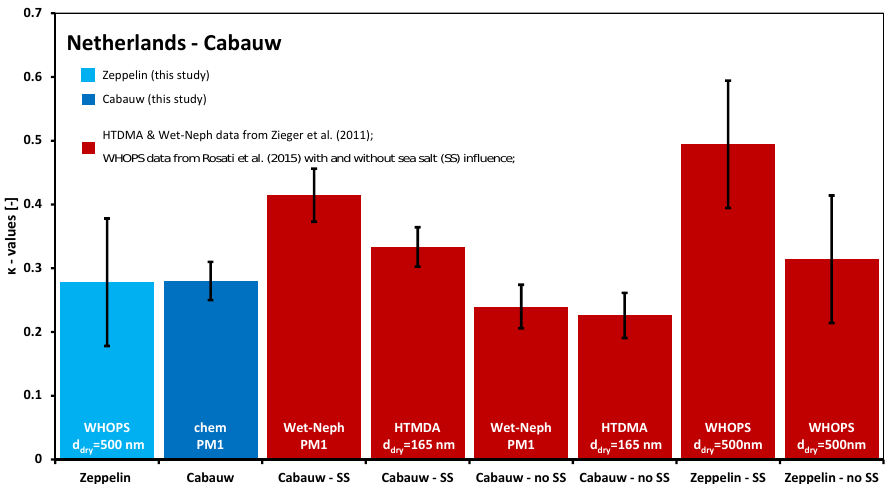
Figure 15. Inter-comparison of mean κ values and their temporal variability measured on board of the Zeppelin NT (light blue bar) and at the ground (dark blue bar) during the PEGASOS campaign on 24 May 2012 in the Netherlands. Additionally, results from two separate campaigns reported in the literature are shown (red bars). For the flight described in Rosati et al. (2015) two separate bars are presented dividing results in sea salt (SS) and non-sea salt (non-SS) influenced periods. In the same way results from Zieger et al. (2011) are split in SS and non-SS periods for measurements performed with two different